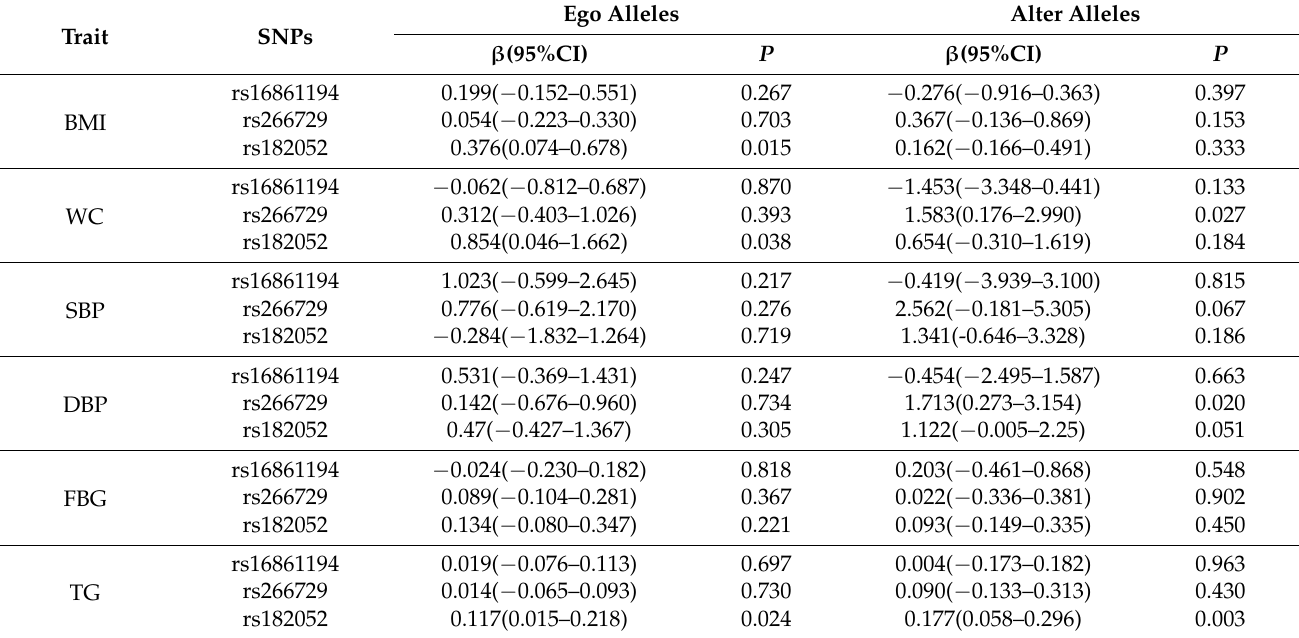
Table 2. The associations with clinical traits for the ego and alter